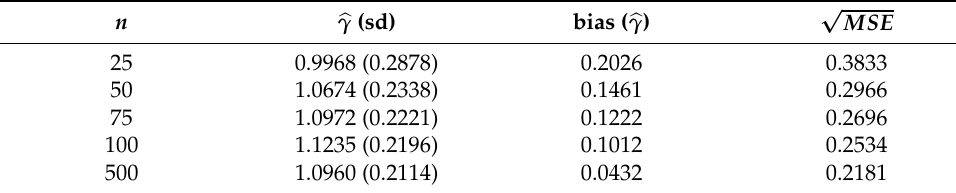
Table 5. Simulations for (cid:98) γ .